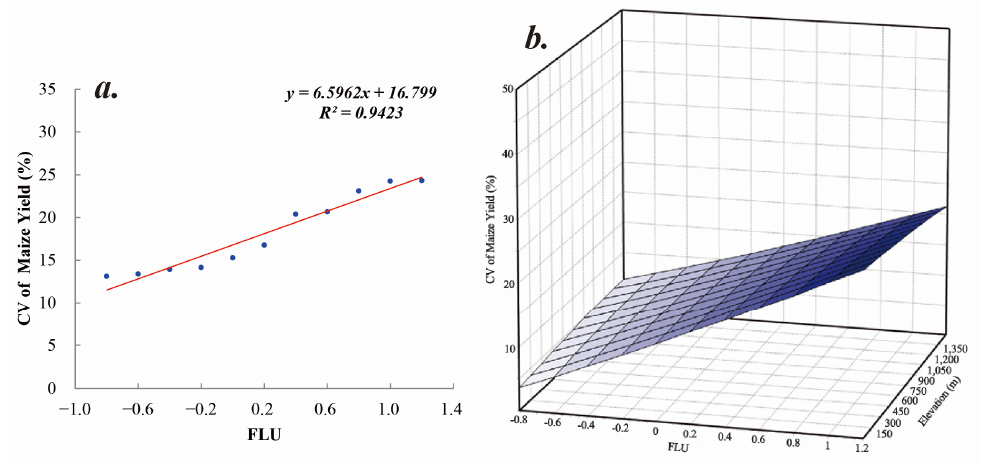
Figure 9. Comparison of vulnerability curve ( a ) and vulnerability surface ( b ).